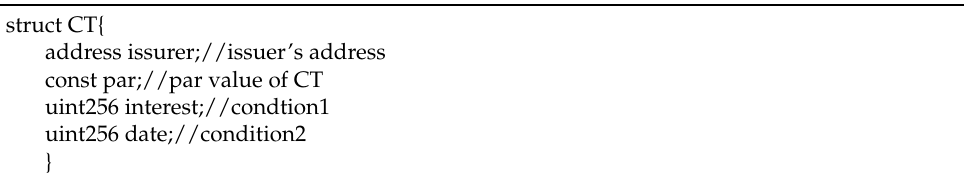
Table 1. Example of CT programmed by